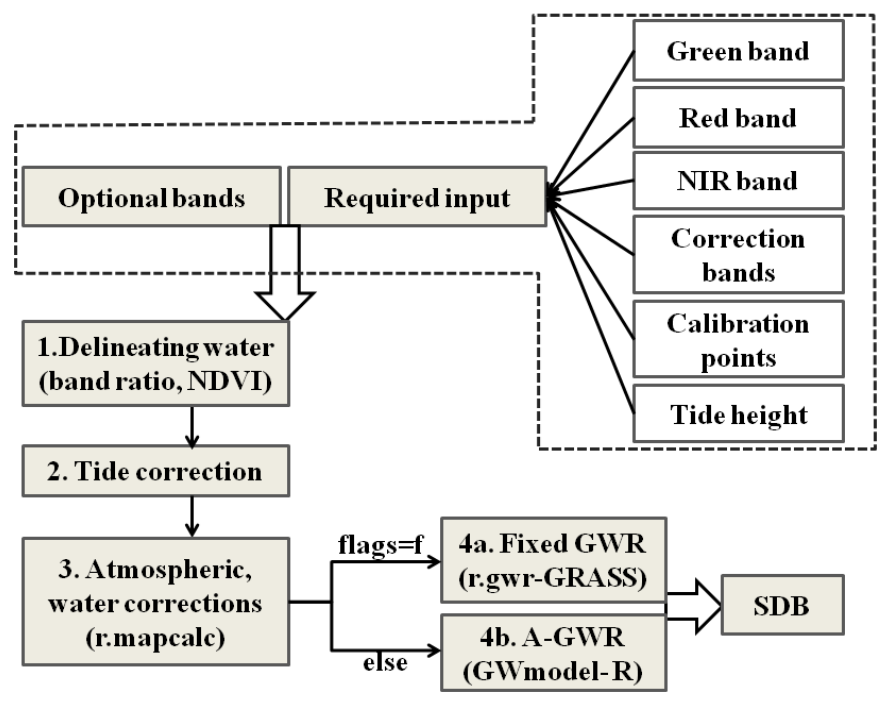
Figure 1. Flowchart of the workflow of i.image.bathymetry .